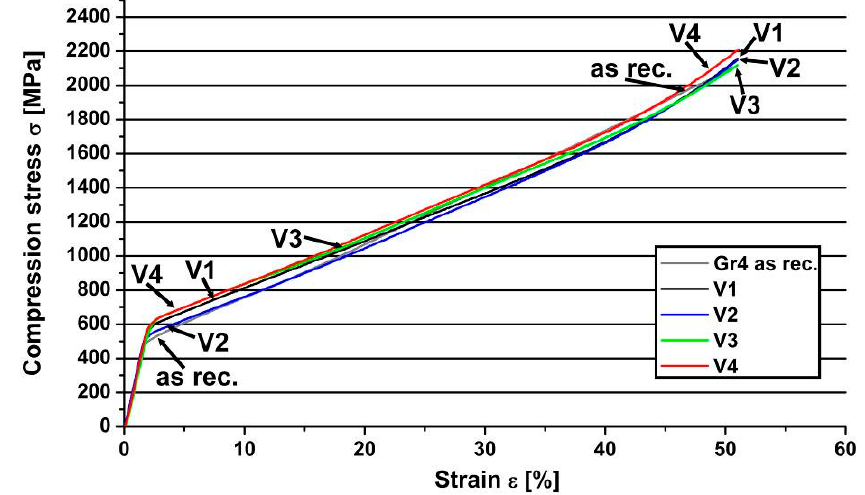
Figure 12. Strain-stress curves obtained from the compression tests.